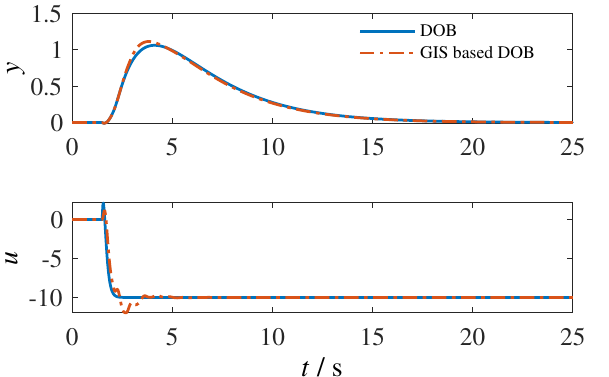
Figure 8. The curves of response y and control output u with a step external disturbance for Example 3 under DOBC and GIS-based DOBC.